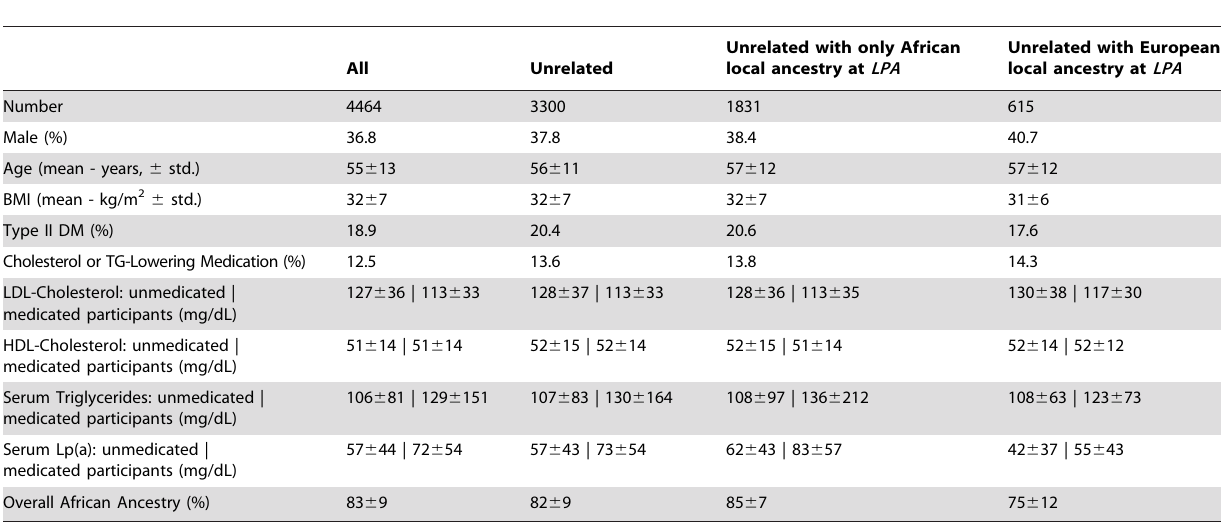
Table 1. Demographic Characteristics for the Genotyped Jackson Heart Study Participants.